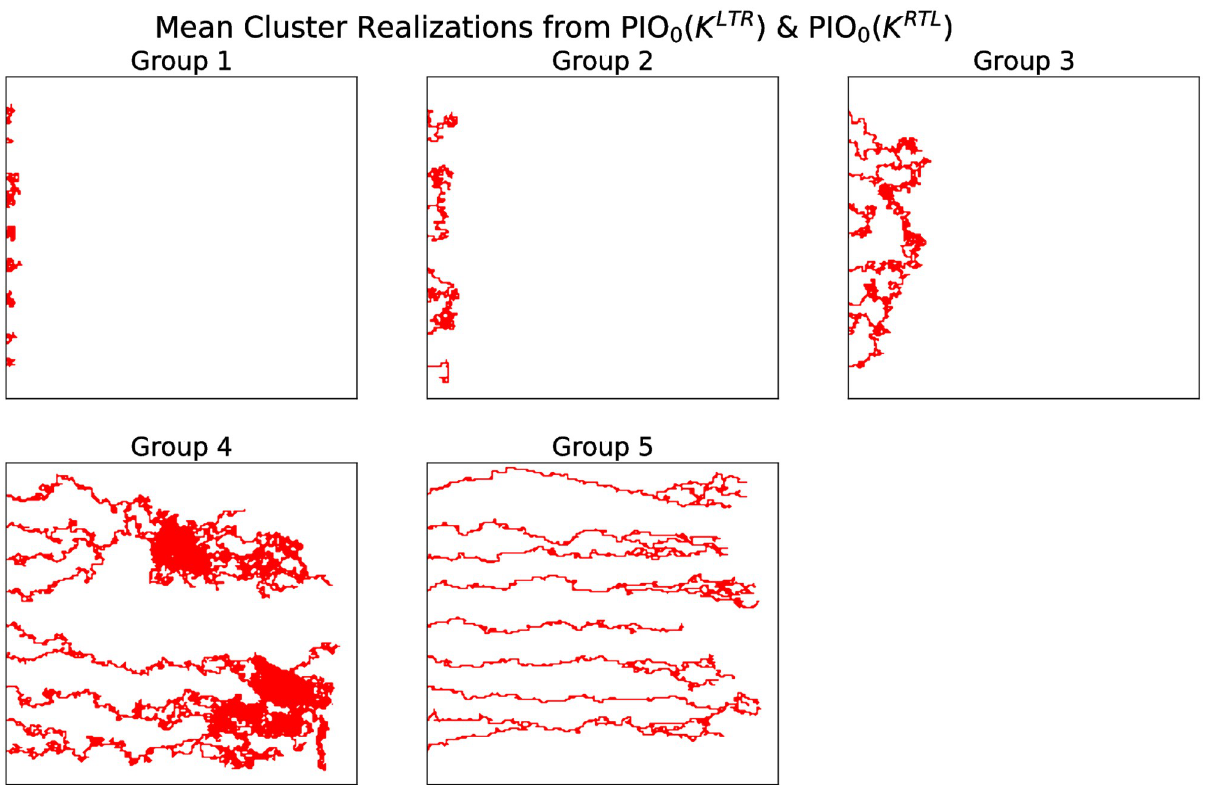
Fig 14. Representative simulated blood vessel networks from Groups 1–5. Series of simulations that resemble the means from each of the five groups (as identified from the double descriptor vectors associated with the sweeping plane filtrations PIO 0 ( K LTR ) & PIO 0 ( K RTL )). The representative simulations for groups 1–5 were generated using the following pairs of parameter values: ( ρ , χ ) = (0.25, 0), (0.5, 0.2), (0.3, 0.2), (0.15, 0.15), and (0.2, 0.4),